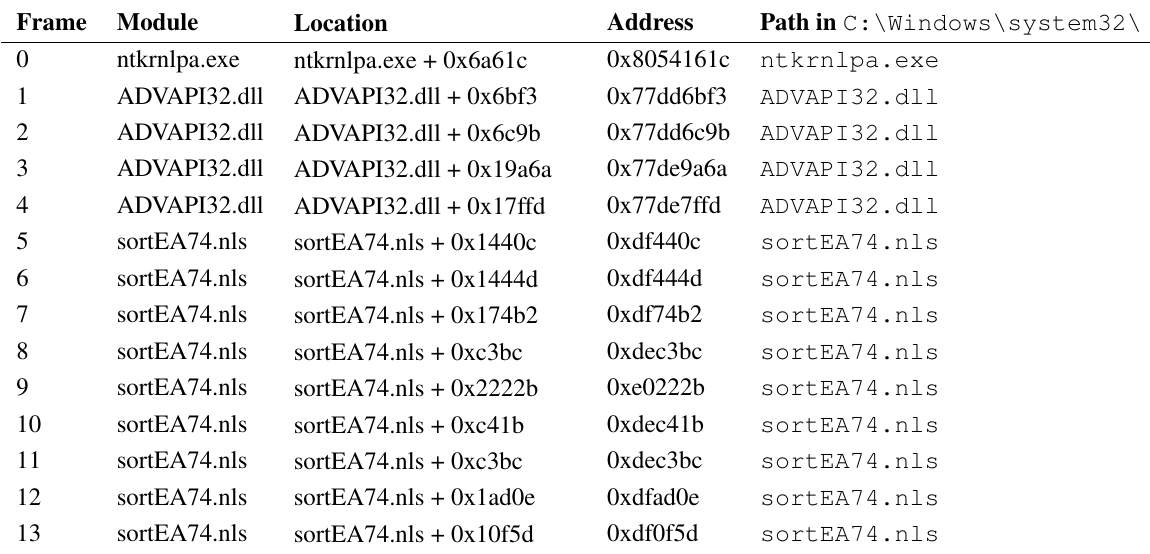
Table 2. Examining the stack trace of a newborn lsass.exe process on a Duqu infected machine with Process